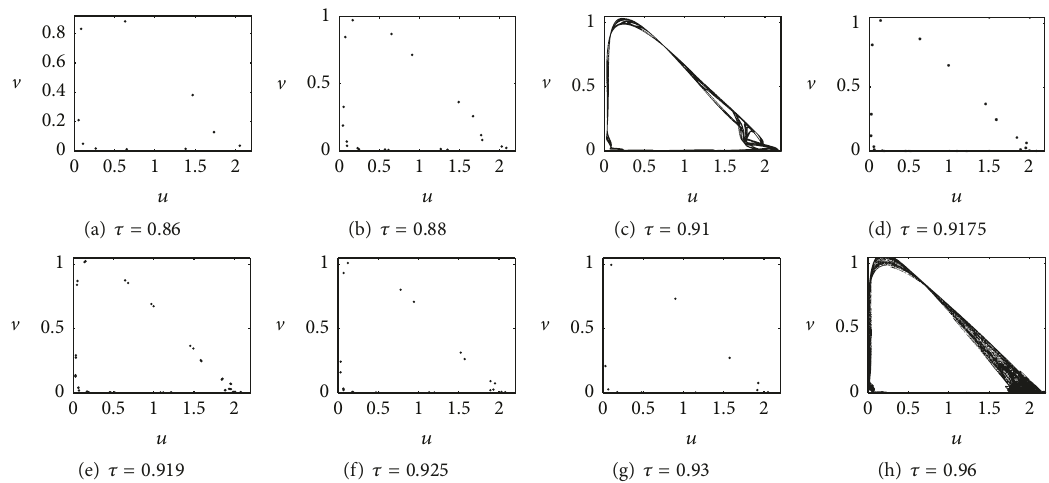
Figure 10: Phase portraits for various values of 𝜏 corresponding to Figure 9(a).